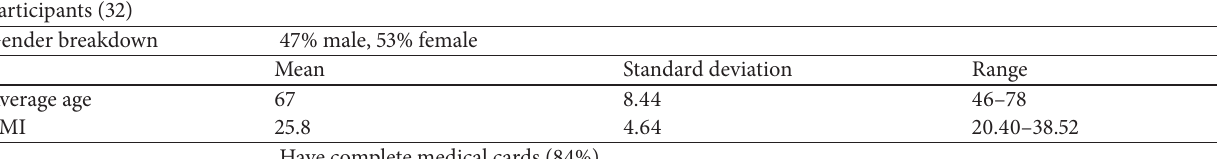
Table 1: Focus group participant